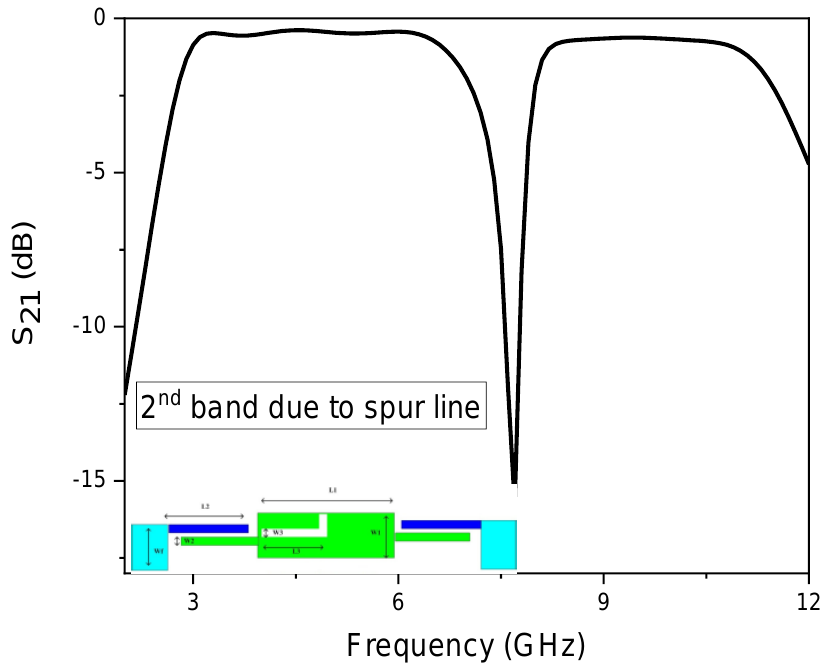
Figure 11. S 21 plot of UWB notch filter with embedded spur line structure. The interesting property of the proposed filter is the independently controlled of both stopbands with the parameters L 4 , L 5 , W 6 , L 3 , and W 3 , i.e., by enlarging the parameter L 4 from 2 mm to 5 mm, a large variation could be seen in the first stopband, while the second notch band was almost constant, as shown in Figure 12. Similarly, by varying the width W 6 and the length L 5 , a small variation was again obtained, while the second notch band at 7.5 GHz was not changed, as illustrated in Figures 13 and 14, respectively.